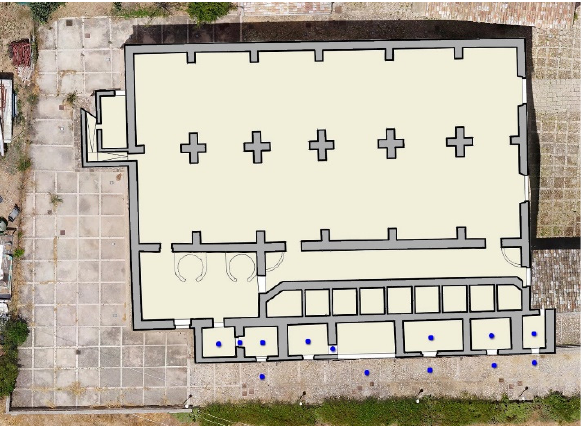
Figure 8 . Scans positions (in blue) for the survey of the ground